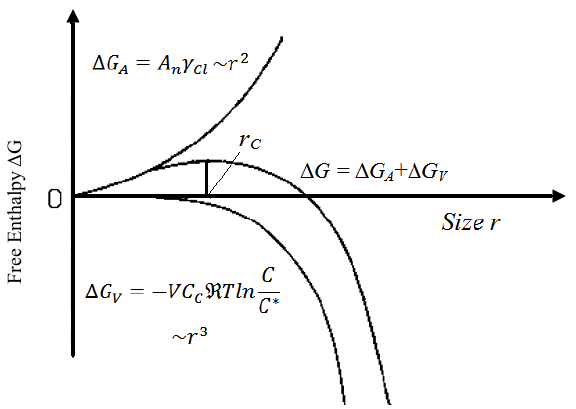
Fig. 1: Free enthalpy ΔG against nucleus size r